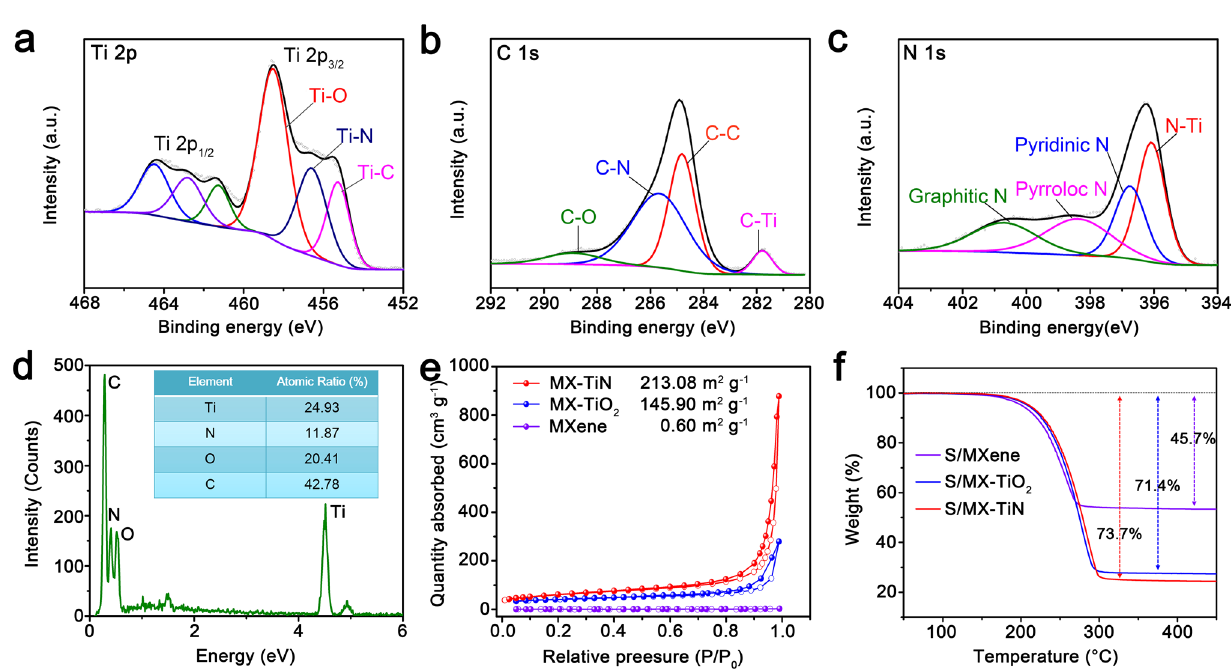
Fig. 2 a Ti 2 p , b C 1 s , and c N 1 s XPS profiles of MX‑TiN. d Elemental compositions of MX‑TiN by EDS analysis. e Nitrogen adsorption–des‑ orption isotherms of MX‑TiN, MX‑TiO 2 , and MXene. f TGA curves of S/MXene, S/MX‑TiO 2, and S/MX‑TiN in Ar